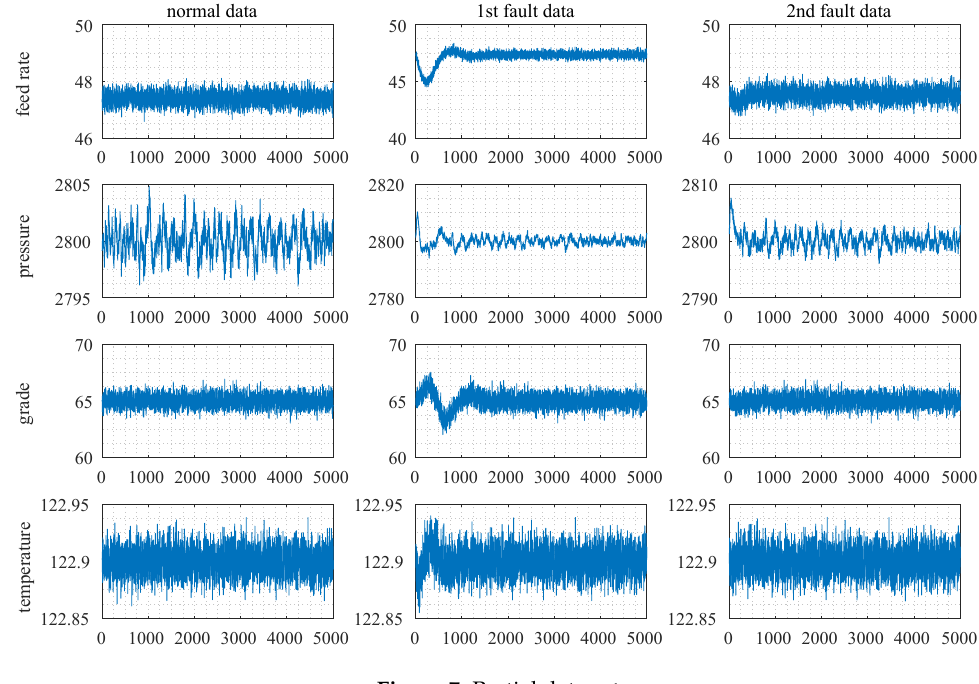
Figure 7. Partial data set. Table 3. The relationship between the sliding window length and fault identification indicators.